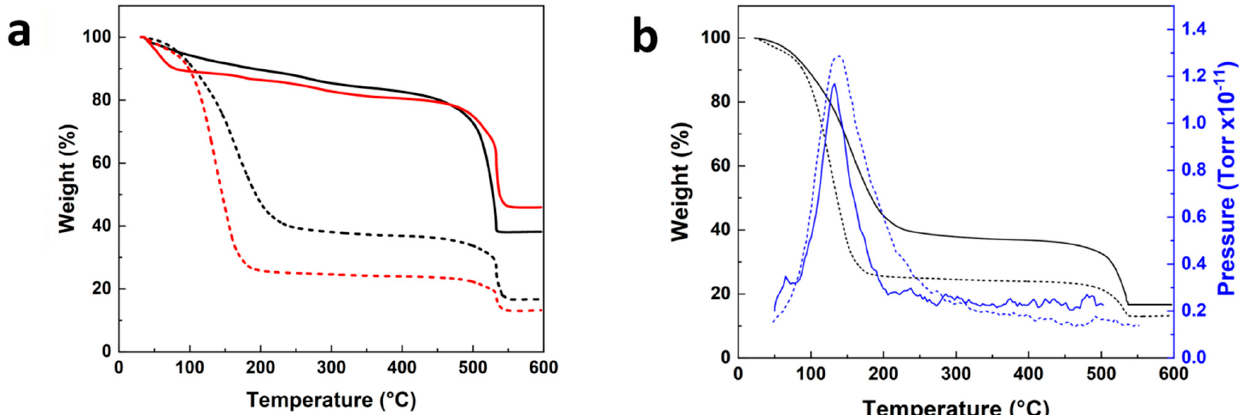
Figure 3. ( a ) TGA for UiO-66 (black) and UiO-66-FA (red); dashed lines indicate I 2 -loaded samples. ( b ) TGA-MS results (black line) for I 2 -loaded UiO-66 (solid line) and I 2 -loaded UiO-66-FA (dashed).